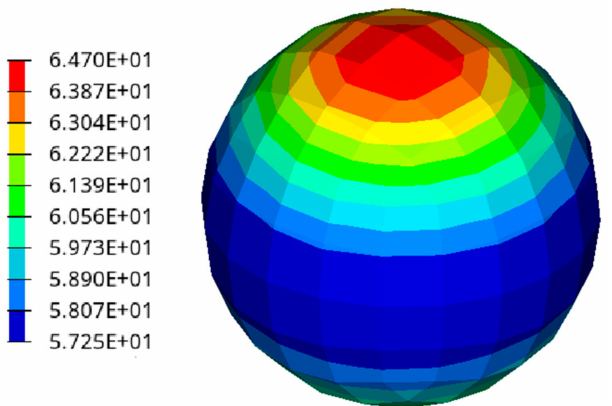
Figure 18. The sound pressure level in (dB) on the chromatic microphone sphere.